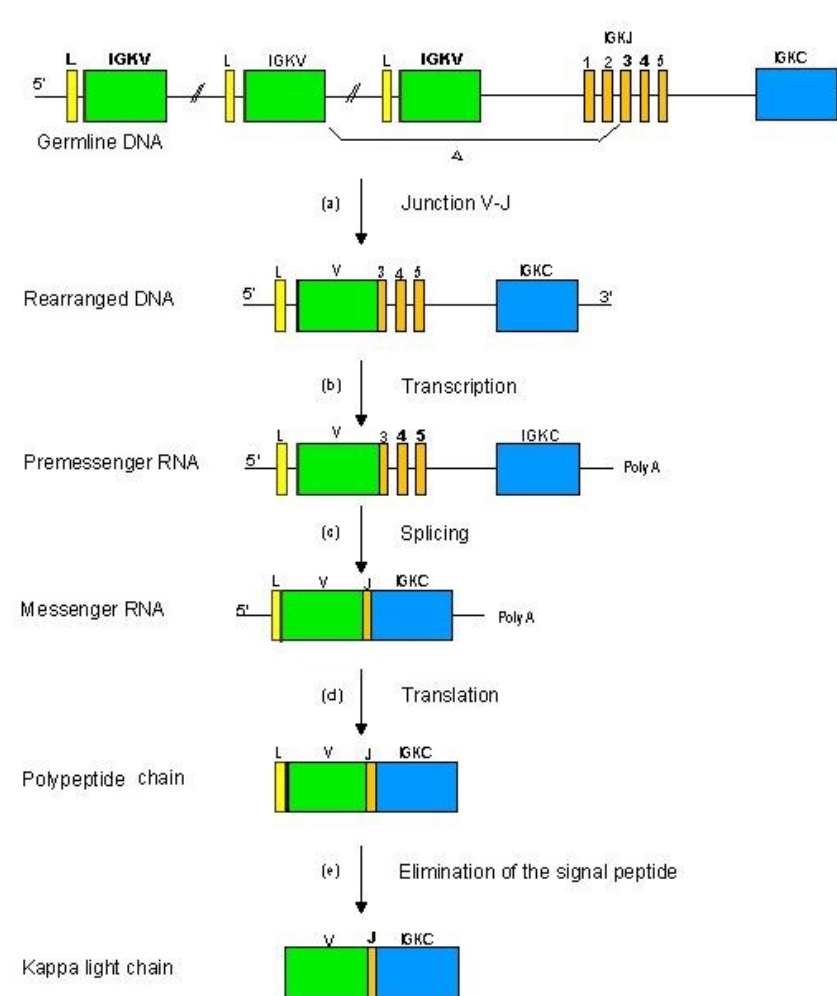
Figure 8. Synthesis of a L-kappa chain [2]. ( a ) At the DNA level, one of the IGKV gene is joined to one of the five IGKJ genes, with deletion of the intermediary DNA, to create a rearranged IGKV-J gene. ( b ) The rearranged IGKV-J sequence is transcribed with the IGKC gene into a IGKV-J-C pre-messenger RNA. ( c ) The RNA sequences corresponding to the introns and to the non-used IGKJ genes are excised by splicing, and a mature messenger which comprises the spliced coding regions, and the 5 (cid:48) and 3 (cid:48) untranslated sequences, is obtained. ( d ) The messenger RNA is translated into a polypeptide chain by the ribosomes. ( e ) The signal peptide is cleaved o ff by a peptidase following the entry of the polypeptide chain in the endoplasmic reticulum, and a mature L-kappa chain is produced. In DNA and pre-messenger RNA, L for Leader corresponds to L-PART1 and L-PART2, and in spliced messenger RNA to L-REGION [2]. (With permission from M-P. Lefranc and G. Lefranc, LIGM, Founders